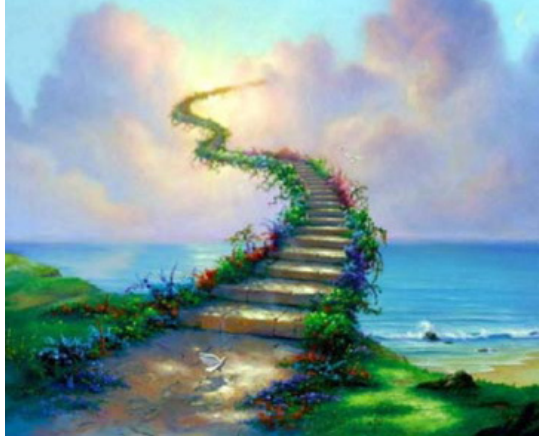
Figure 7. A picture of the rainbow bridge